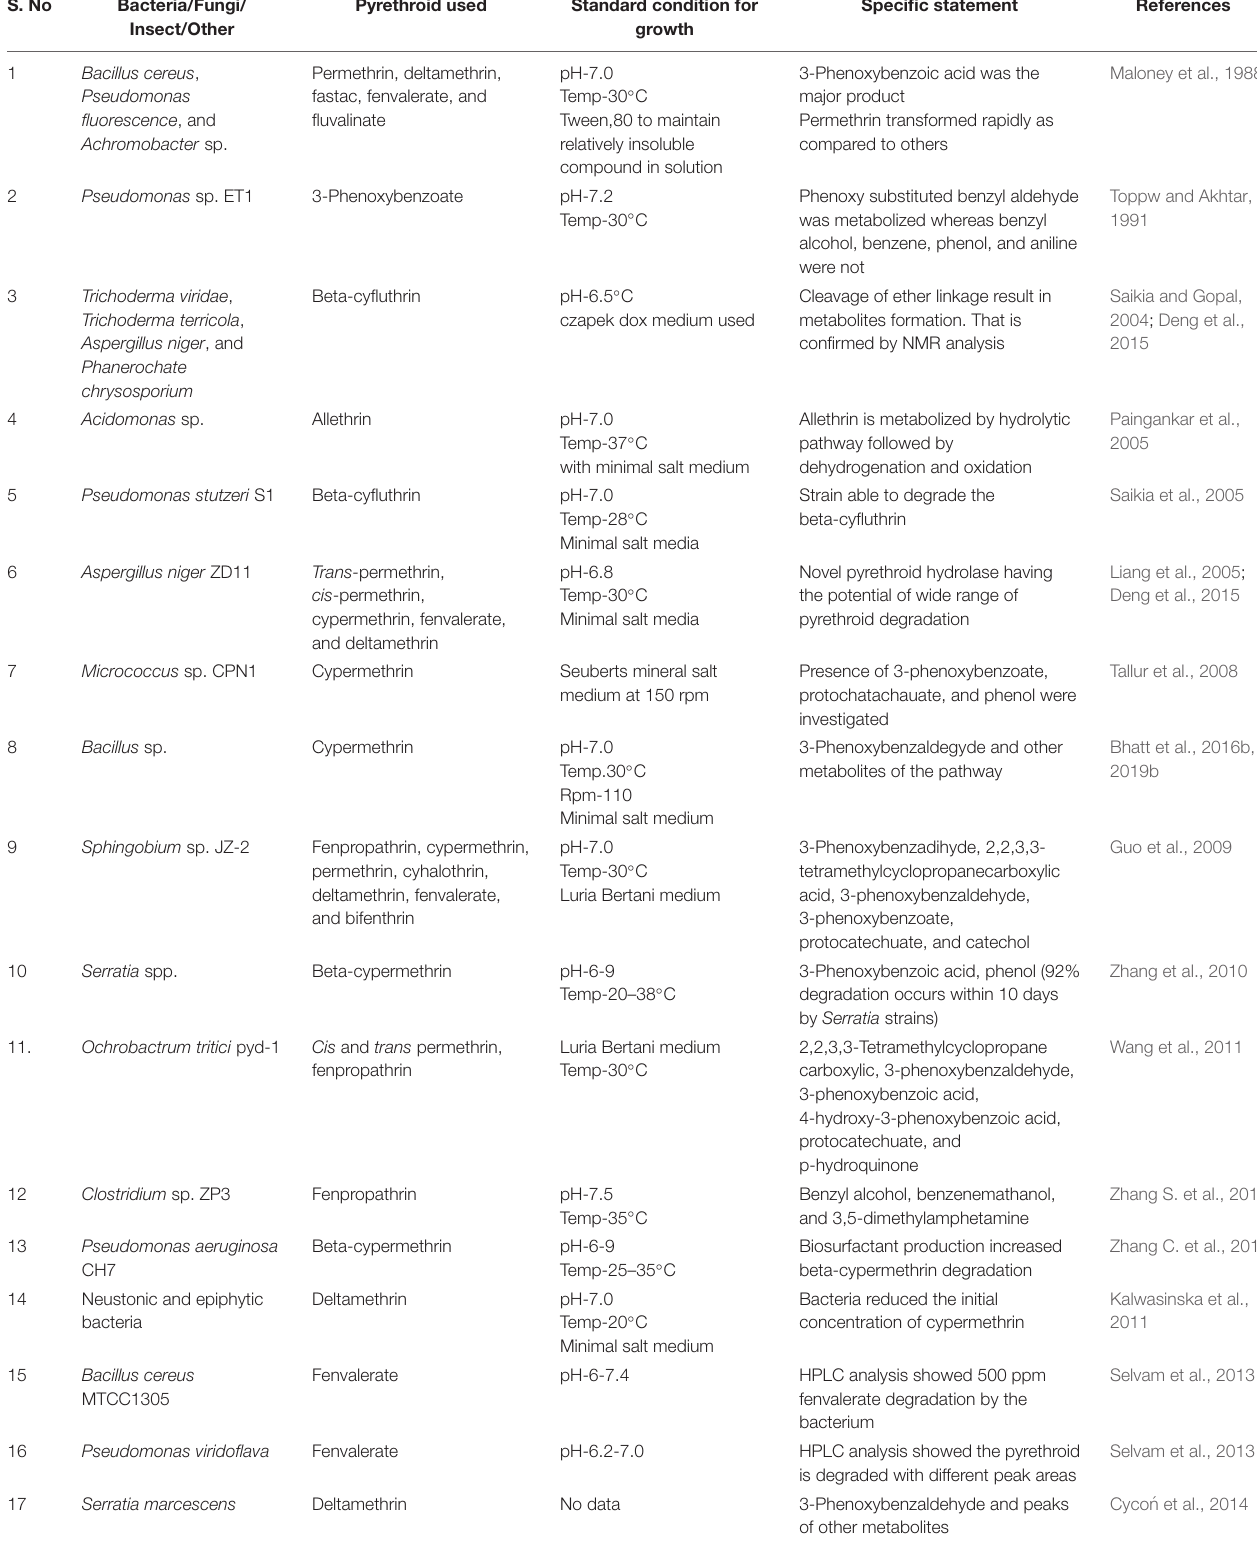
TABLE 3 | Pyrethroid degrading microorganisms and their optimized conditions in lab/field. S.